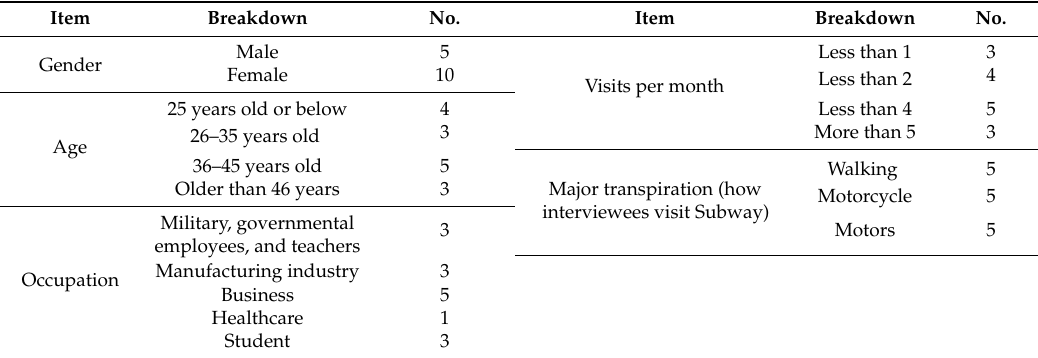
Table 3. Participant information in focus group ( n = 15).